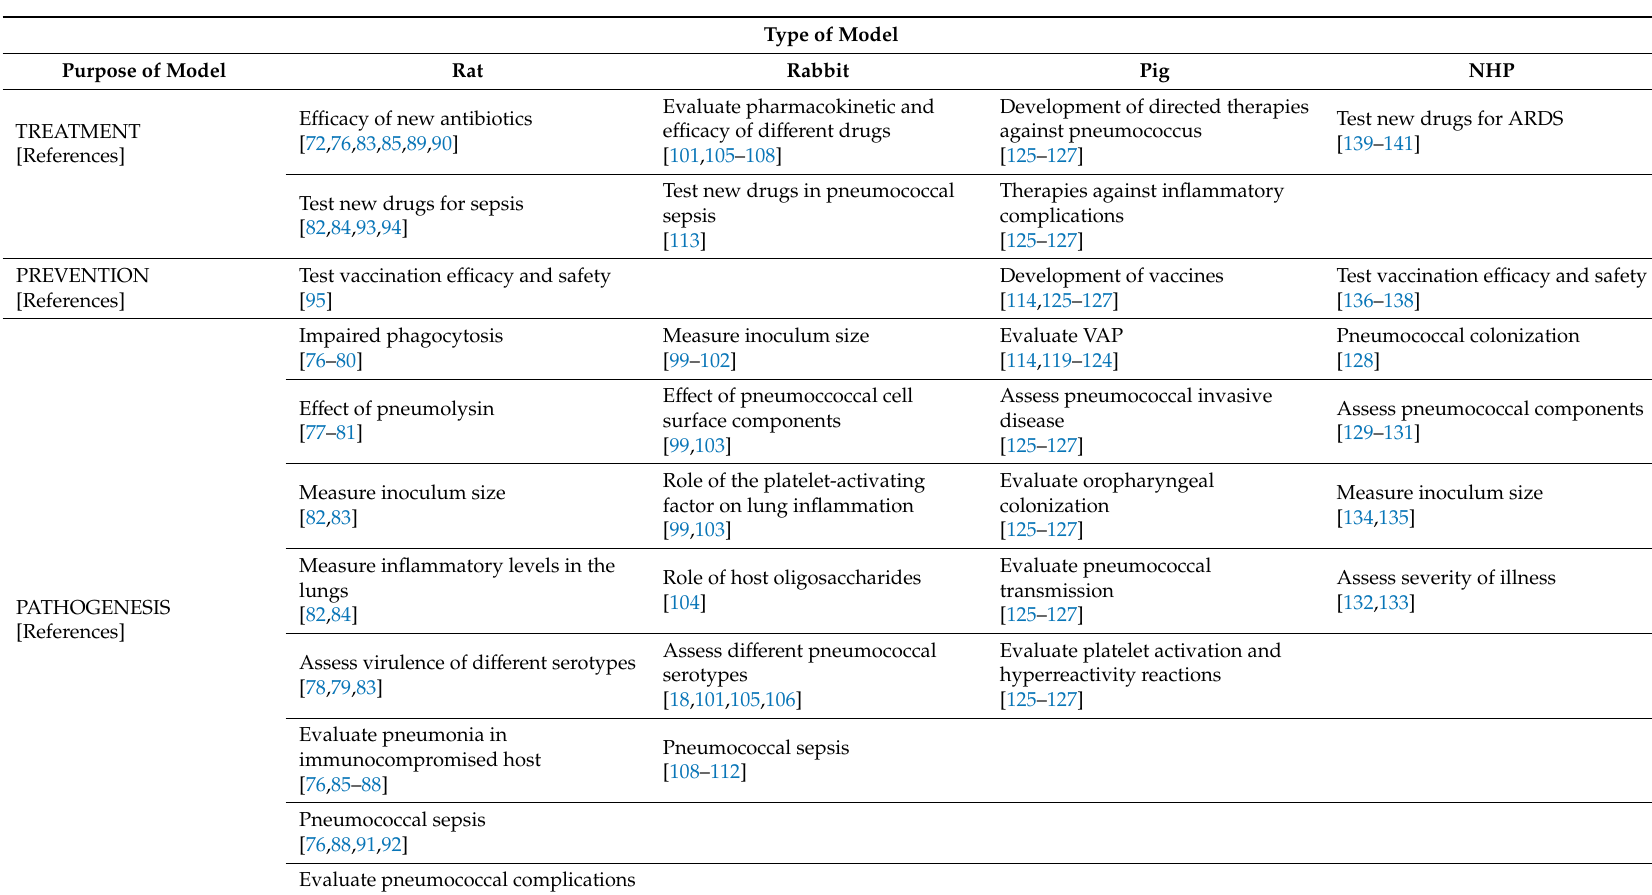
Table 3. Summary of the specific aims of the animal models cited in the present